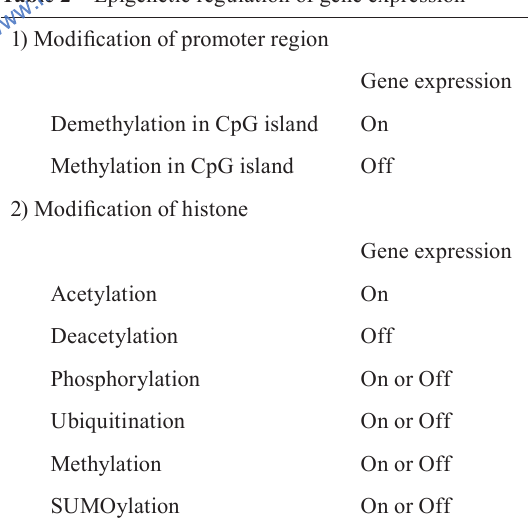
Table 2 Epigenetic regulation of gene expression 1) Modification of promoter